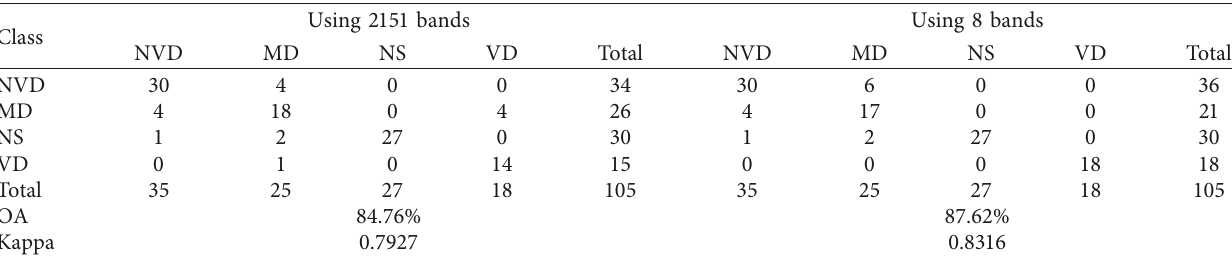
Table 7: Error matrices showing the overall accuracy and kappa for the classification of the four soil classes, nonvitrified dung (NVD), midden (MD), nonsites (NS), and vitrified dung (VD), using all variables (2151 bands) and the optimum variables (8